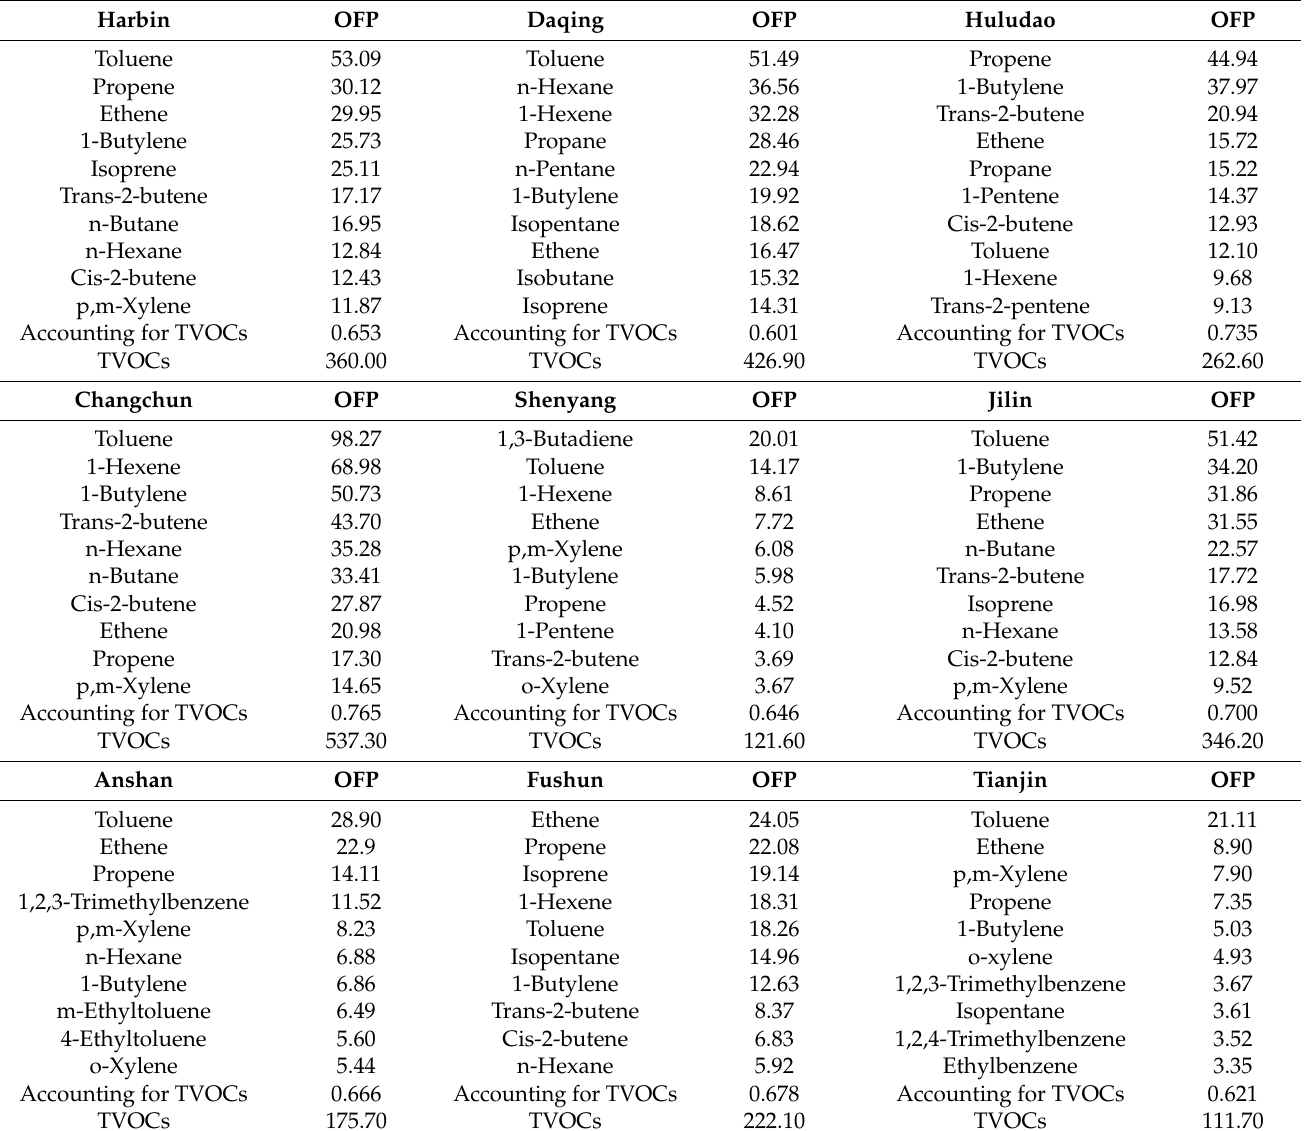
Table 3. Top ten species of contributions to ozone formation ( µ g/m 3 ) by different VOC species in nine cities of